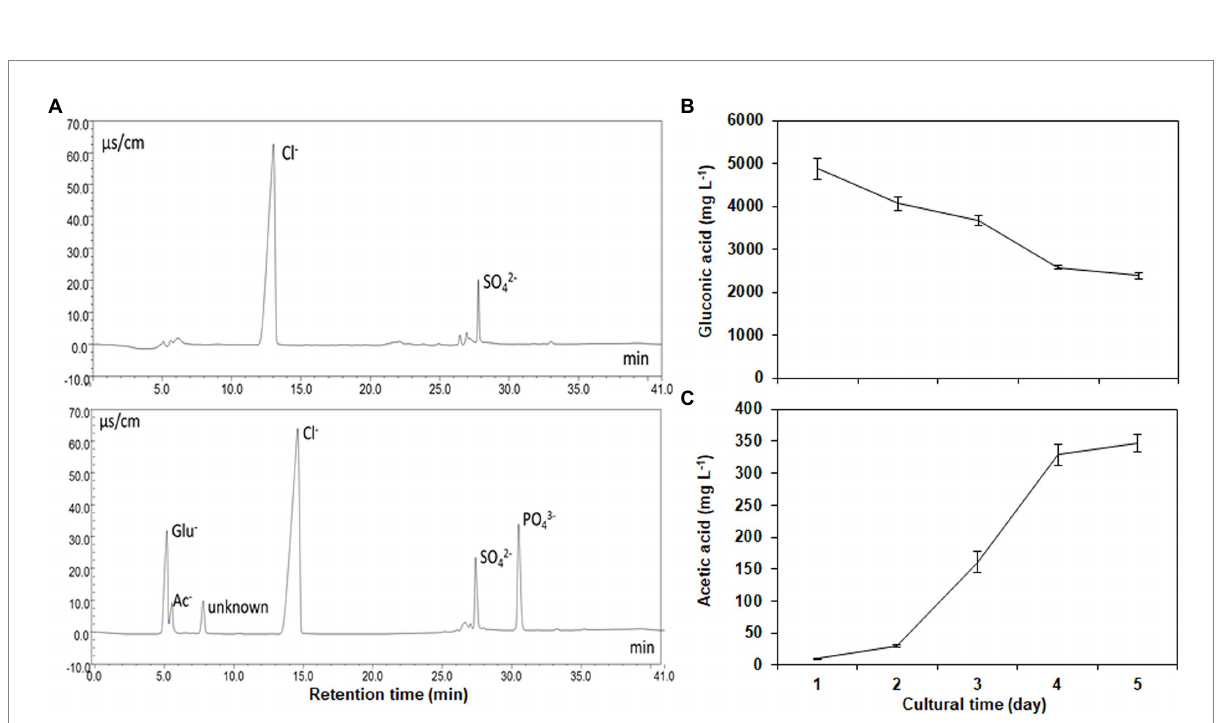
FIGURE 3 Separation of organic acids and inorganic anions using an IonPac AS11-SC analytical column (A) , and the production of gluconic acid (B) and acetic acid (C) by inoculating the strain NG-33 on the NBRIP liquid medium.